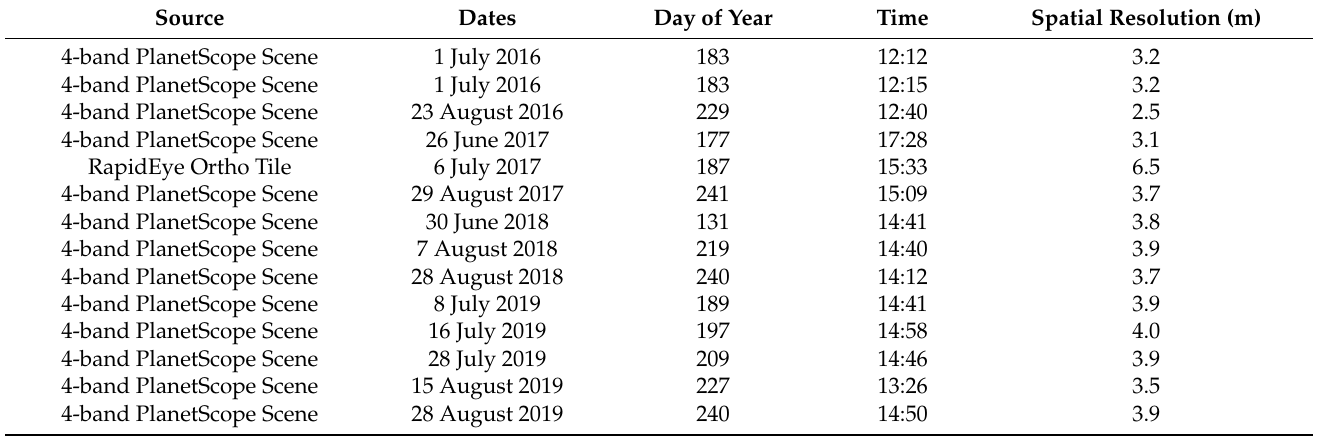
Table 2. List of Planet satellite images used in the